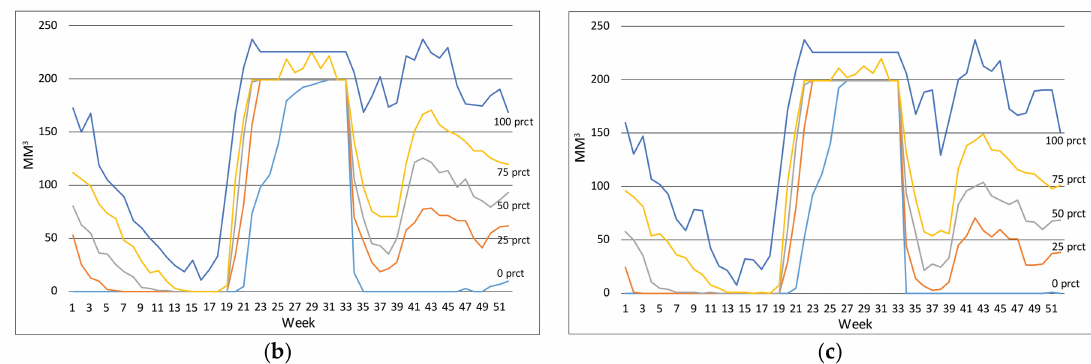
Figure 5. Percentiles (0, 25, 50, 75, 100) reservoir level week-by-week over the year for Kvilldal (max 237 MM3): ( a ) Present hydropower generation capacity (0 GW extra); ( b ) 2 GW extra capacity in plant downstream to the reservoir (11 GW extra in Norway); ( c ) 3.4 GW extra capacity in plant downstream to the reservoir (19 GW extra in Norway).